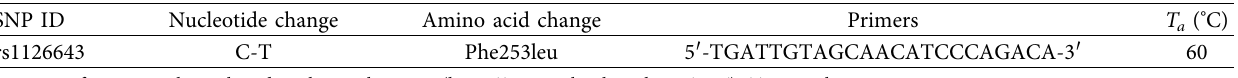
Table 1: Single-nucleotide polymorphism of platelet glycoprotein Ia/IIa analysed and relative primers used in the study.